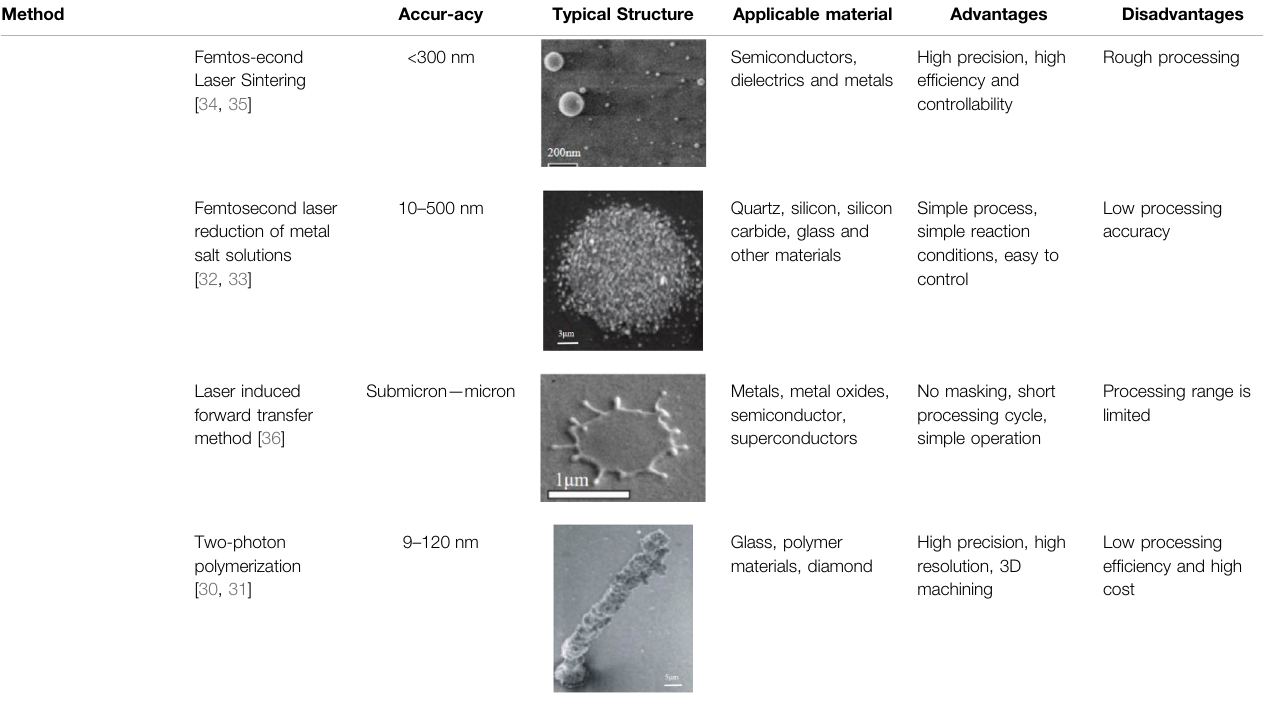
TABLE 1 | ( Continued ) Summary of preparation methods for plasma nanostructures of precious metals, including processing accuracy, advantages and disadvantages.